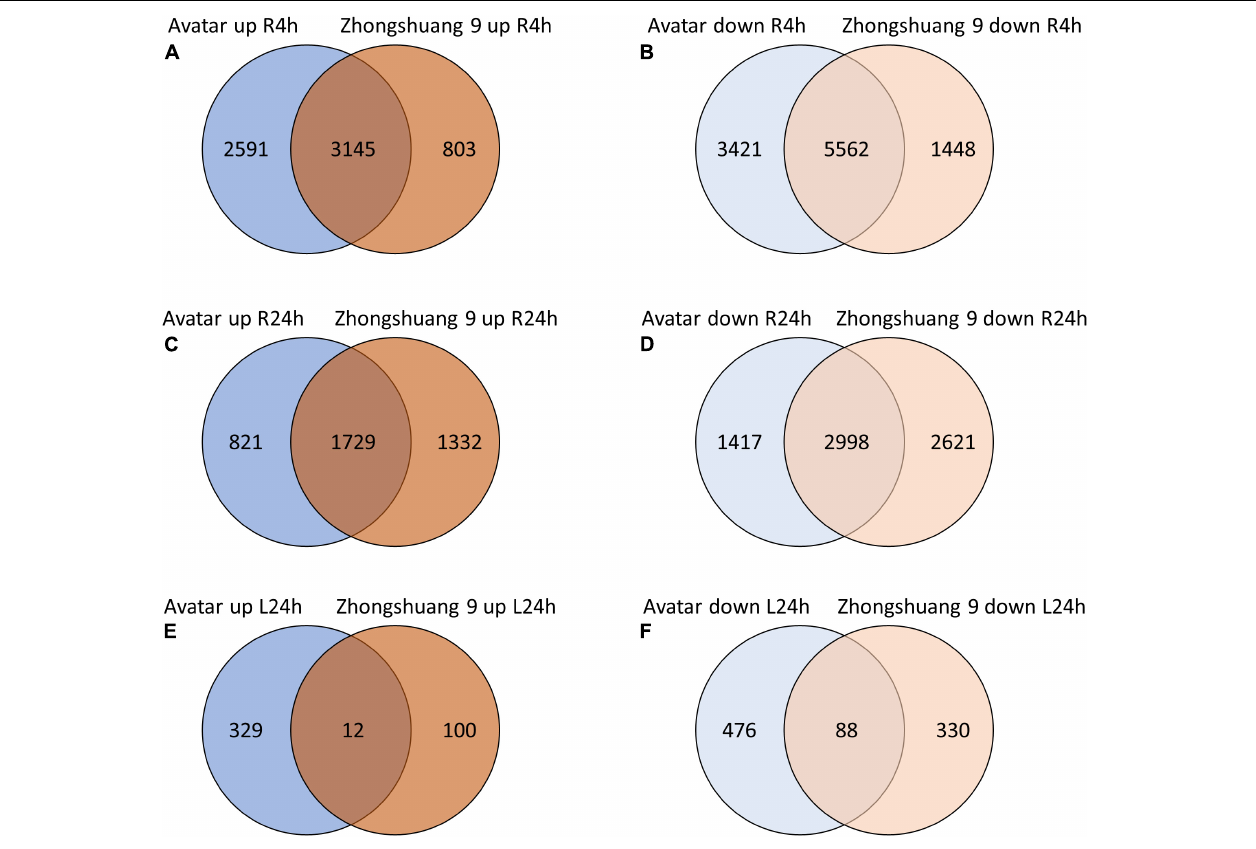
FIGURE 1 | Venn diagrams showing overlaps of induced (A,C,E) or repressed (B,D,F) genes between two Brassica napus cultivars (Avatar, Zhongshuang 9) in hydroponics after 4 and 24 h of root hypoxia, compared with aerated controls. (A,B) Roots were treated with 4 h of hypoxia; (C,D) Roots were treated with 24 h of hypoxia; (E,F) Leaves of plants treated with root hypoxia for 24